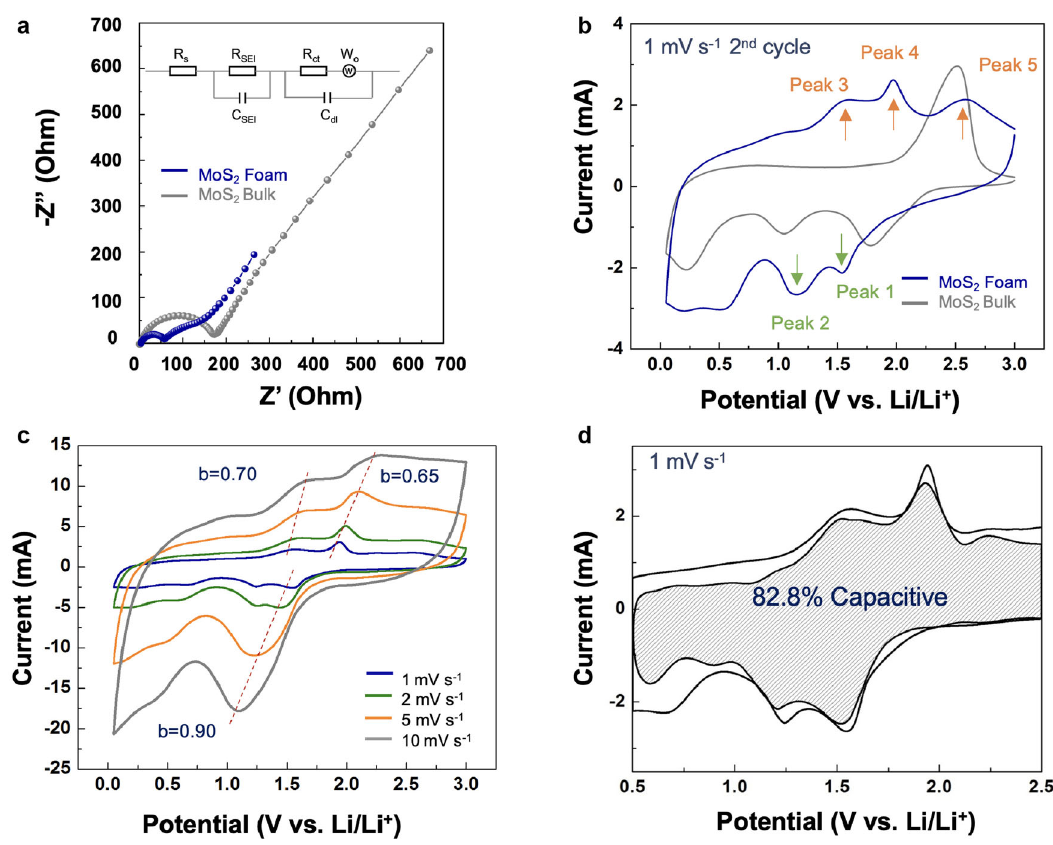
Fig. 4 | Pseudocapacitive charge storage contributes to the MoS 2 foam ’ s excellentratecapacity.a NyquistplotsofMoS 2 foamandMoS 2 bulkelectrodeata fullydischargedstateaftertencyclesat100mAg − 1 . b CVmeasurementsfeaturethe 2nd cycle of MoS 2 foam and MoS 2 bulk electrodes under 1mVs − 1 in the voltage window between 0.01 – 3V. c Capacitive effects are characterized by analyzing the